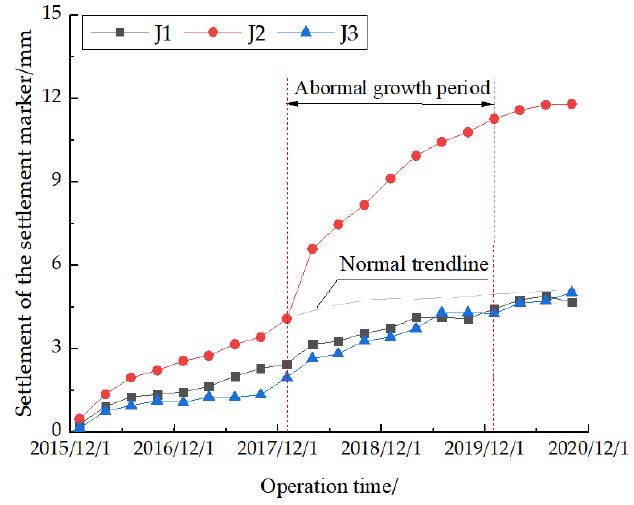
Figure 6. Settlement scale settlement–operation time relationship curve.